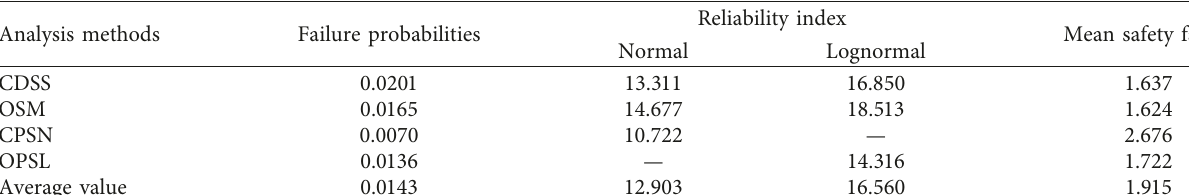
Table 6: Confidence level analysis results.